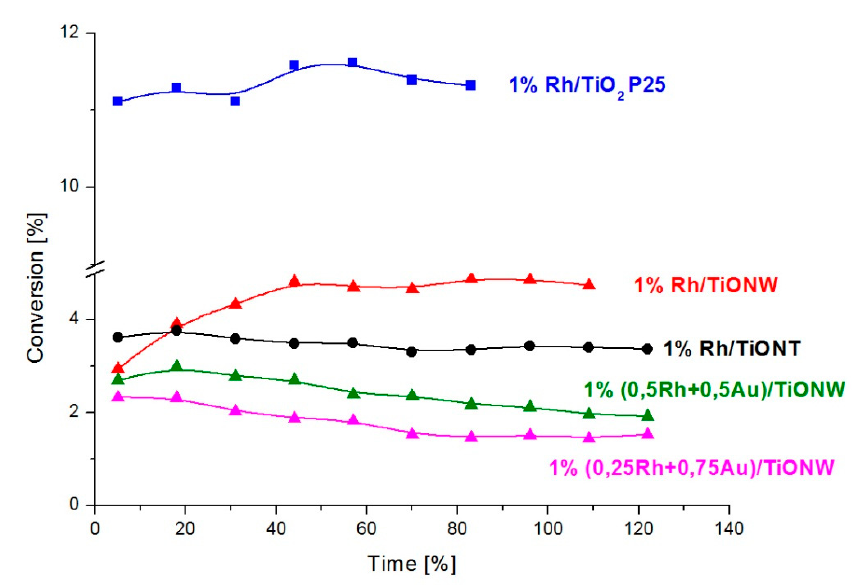
Figure 12. Conversion of the CO + H 2 O reaction over 1% Rh/TiO 2 (Degussa P25), 1% Rh/TiONW, 1% Rh/TiONT, 1% (0.25Rh + 0.75Au)/TiONW and over 1% (0.5Rh + 0.5Au)/TiONW. The reaction temperature was 550 K.